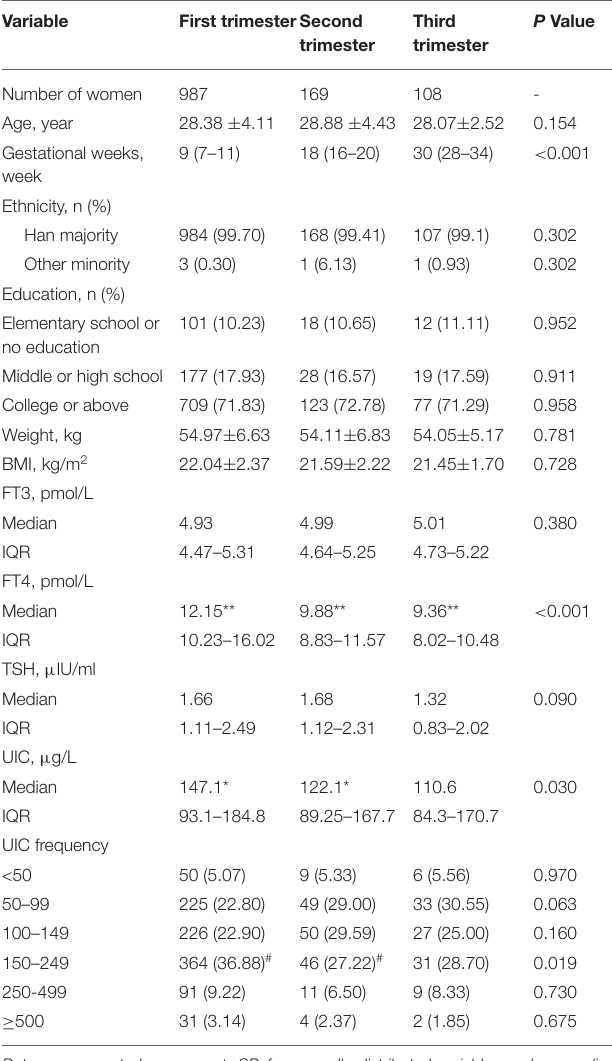
TABLE 1 | Demographic characteristics and urinary iodine concentration frequency distribution based on pregnant trimesters.